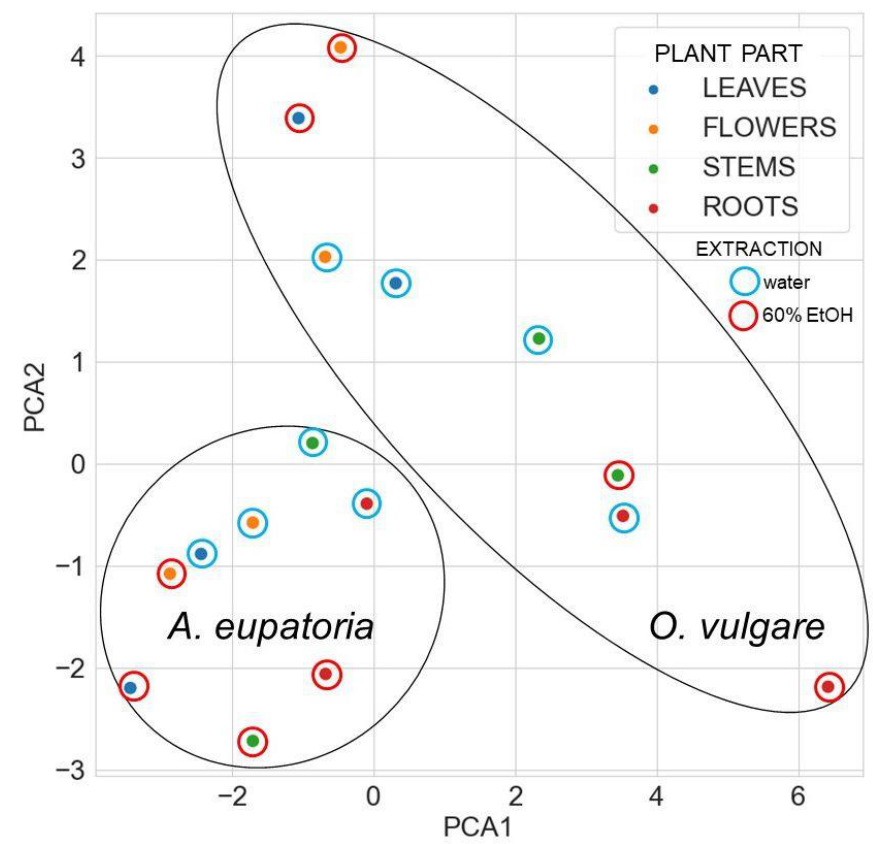
Figure 4. The principal component analysis of identified secondary metabolites in water or 60% ethanol extracts of A. eupatoria and O. vulgare. The analysis compares the composition in the tested extracts against PA-Lux. Data were plotted using the Seaborn library for making statistical graphics in Python [26]. Abbreviations: PA-Lux, luminescent strain of P. aeruginosa .